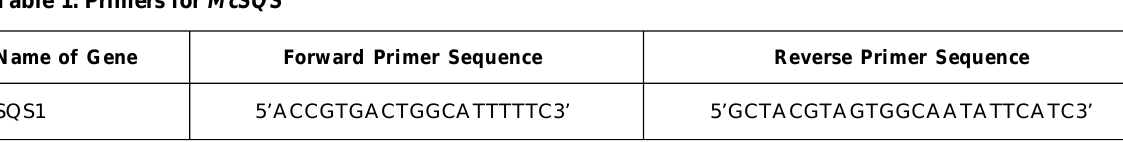
Table 1: Primers for McSQS